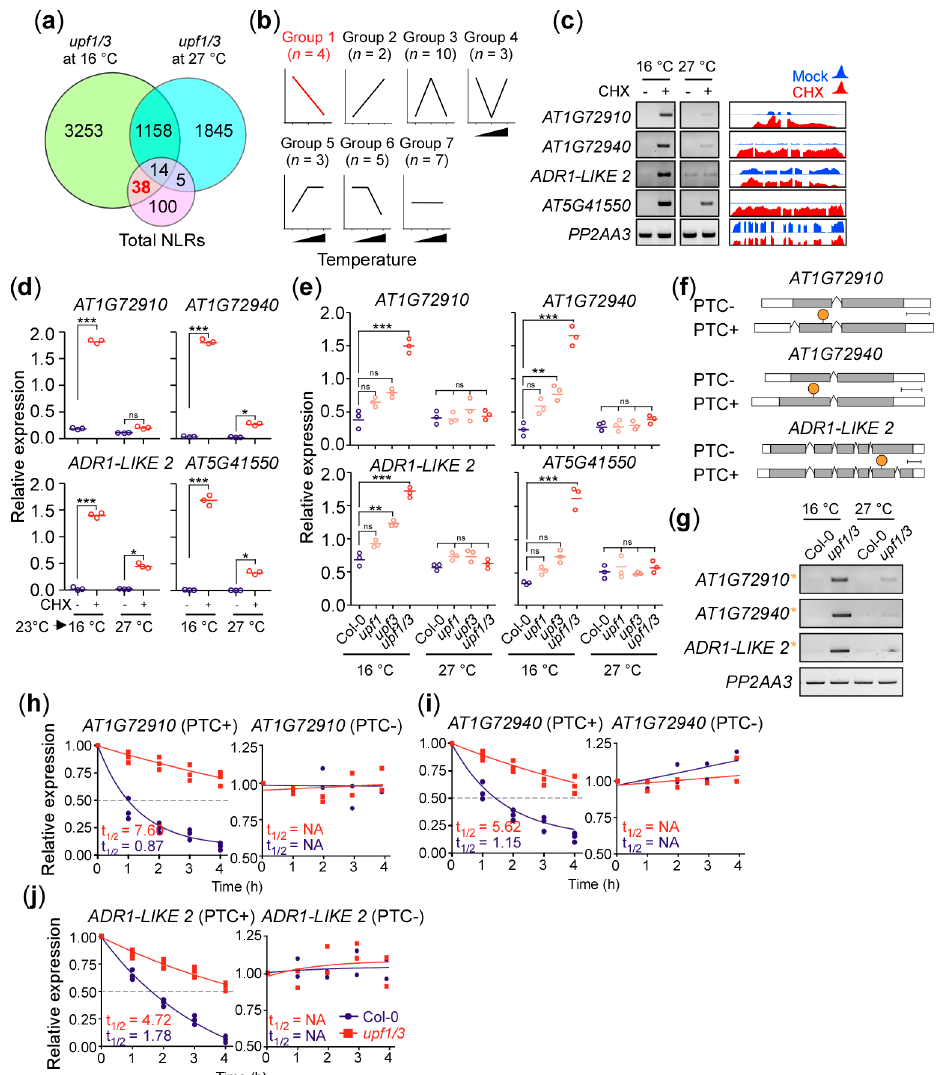
Figure 2. Identification of AT1G72910 , AT1G72940 , and ADR1-LIKE 2 as NLR (nucleotide-binding, leucine-rich repeat) genes regulated by NMD in a temperature-dependent manner. ( a ) Venn diagram highlighting the 38 NLR genes that are upregulated in upf1 / 3 mutants compared with wild type (Col-0) at 16 ◦ C. ( b ) Classification of the 38 NLR genes into seven groups based on their expression patterns in CHX-treated wild-type plants at 16 ◦ C, 23 ◦ C, and 27 ◦ C. n = the number of NLR genes in each group. ( c ) Expression levels of group 1 NLR genes determined by RT-PCR. Read coverage graphs from the public transcriptome data (GSE41432) upon CHX treatment are shown on the right. ( d ) qPCR confirmation of the group 1 NLR genes in CHX-treated wild-type plants. Seedlings were grown at 23 ◦ C and transferred to each temperature for CHX treatment. ( e ) Expression levels of group 1 NLR genes in the upf mutants at 16 ◦ C and 27 ◦ C. ( f ) Map of transcripts with a PTC (PTC + ) and without a PTC (PTC − ) identified from the AT1G72910 , AT1G72940 , and ADR1-LIKE 2 loci. A PTC is indicated by an orange circle. ( g ) Confirmation of the presence of PTC + transcripts (orange asterisk) from AT1G72910 , AT1G72940 , and ADR1-LIKE 2 in upf1 / 3 mutants at 16 ◦ C and 27 ◦ C via RT-PCR. PP2AA3 was used as an internal control. ( h ) mRNA degradation kinetics of the PTC +/ − transcripts of AT1G72910 , ( i ) AT1G72940 , and ( j ) ADR1-LIKE 2 in upf1 / 3 mutants. The half-lives of PTC + transcripts shown for Col-0 and upf1 / 3 mutants. One-way ANOVA with post-hoc Tukey test was used for the statistical comparison of all genotypes. *: p < 0.05; **: p < 0.01, ***: p ≤ 0.001; ns: not significant. NA: not